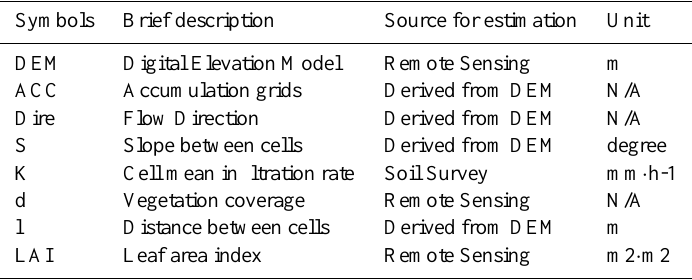
Table 1. Main physically-based parameters in CREST model. Symbols Brief description